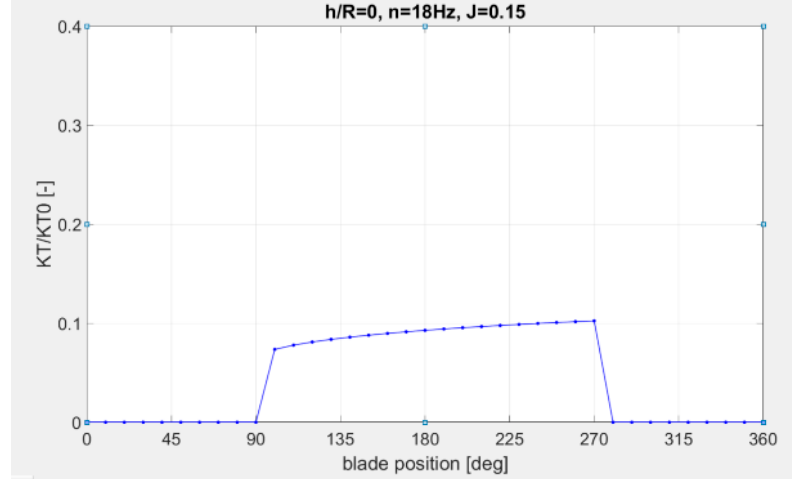
Figure 15 . Thrust loss factor as a function of blade position based on experimental results (Koz10).